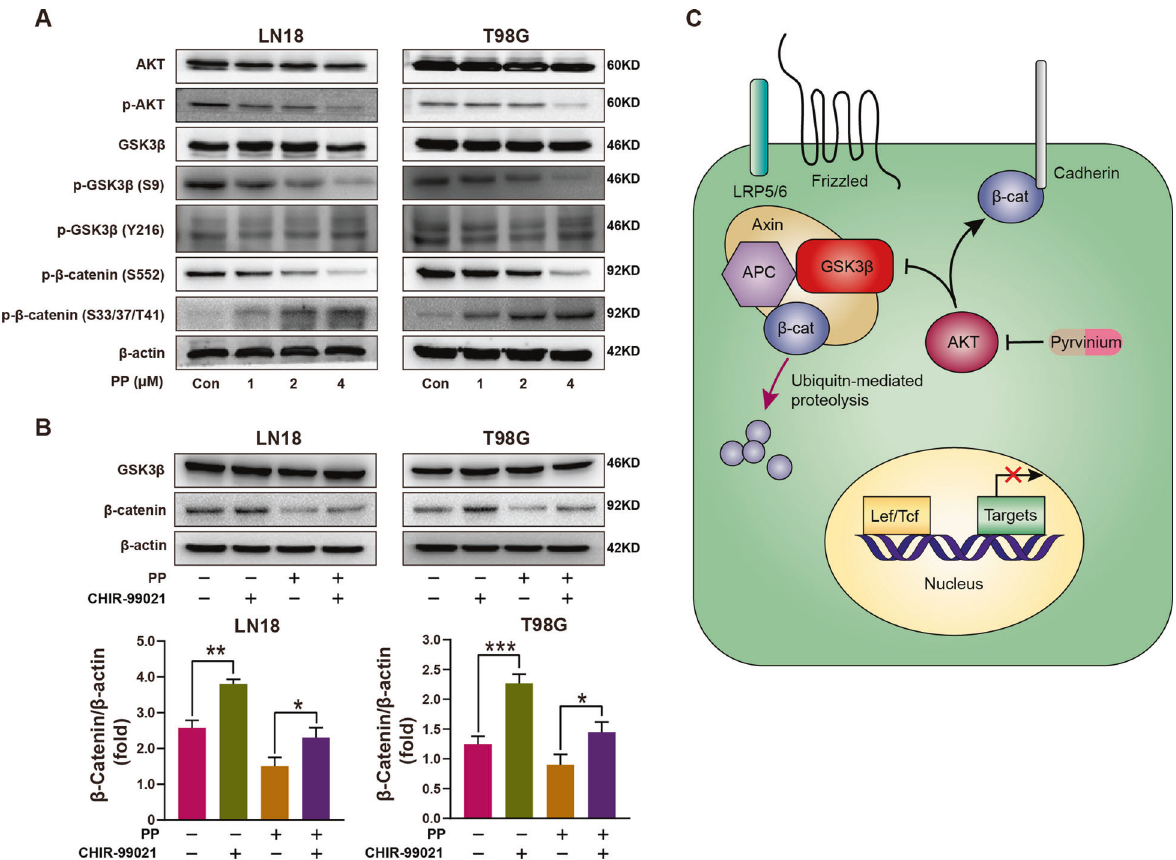
Fig. 6 The underlying mechanism of PP in regulating β -catenin. A The protein levels of AKT, p-AKT, GSK3 β , p-GSK3 β (S9), p-GSK3 β (Y216), p- β -catenin (S552), and p- β -catenin (S33/37/T41) were evaluated through western blotting following PP treatment at different contents. B Effect of pretreatment with GSK3 β inhibitor CHIR-99021 on PP-induced β -catenin down-regulation (top panel). Densitometric analysis of β -catenin/ β -actin expression fold change (bottom panel). C Schematic diagram for the underlying mechanism by which PP regulated β -catenin. PP inhibits the activation of AKT, thereby increasing the activity of GSK3 β , leading to increased degradation of β -catenin by multi-protein destruction complex, which mainly includes Axin, APC, and GSK-3 β . β -catenin has at least two distinct pools. One is located in cytoplasm which binds with E-cadherin, and the other one is involved in the Wnt signaling pathway so that shuttles between cytoplasm and nucleus [45]. AKT mediates the phosphorylation of β -catenin associated with plasma membrane, and then induces the dissociation of β -catenin from E-cadherin, which accumulates in cytoplasm and nucleus [30]. In the case of PP addition, PP reduces the p-AKT protein level and further down- regulates p- β -catenin (S552) expression in the cells. Consequently, dissociation of β -catenin from E-cadherin within cell membrane is reduced, so that the combination of β -catenin with the LEF/TCF transcription factors in cell nucleus is reduced, either, which hinders the activation of MGMT gene. * p < 0.05; ** p < 0.01; *** p <